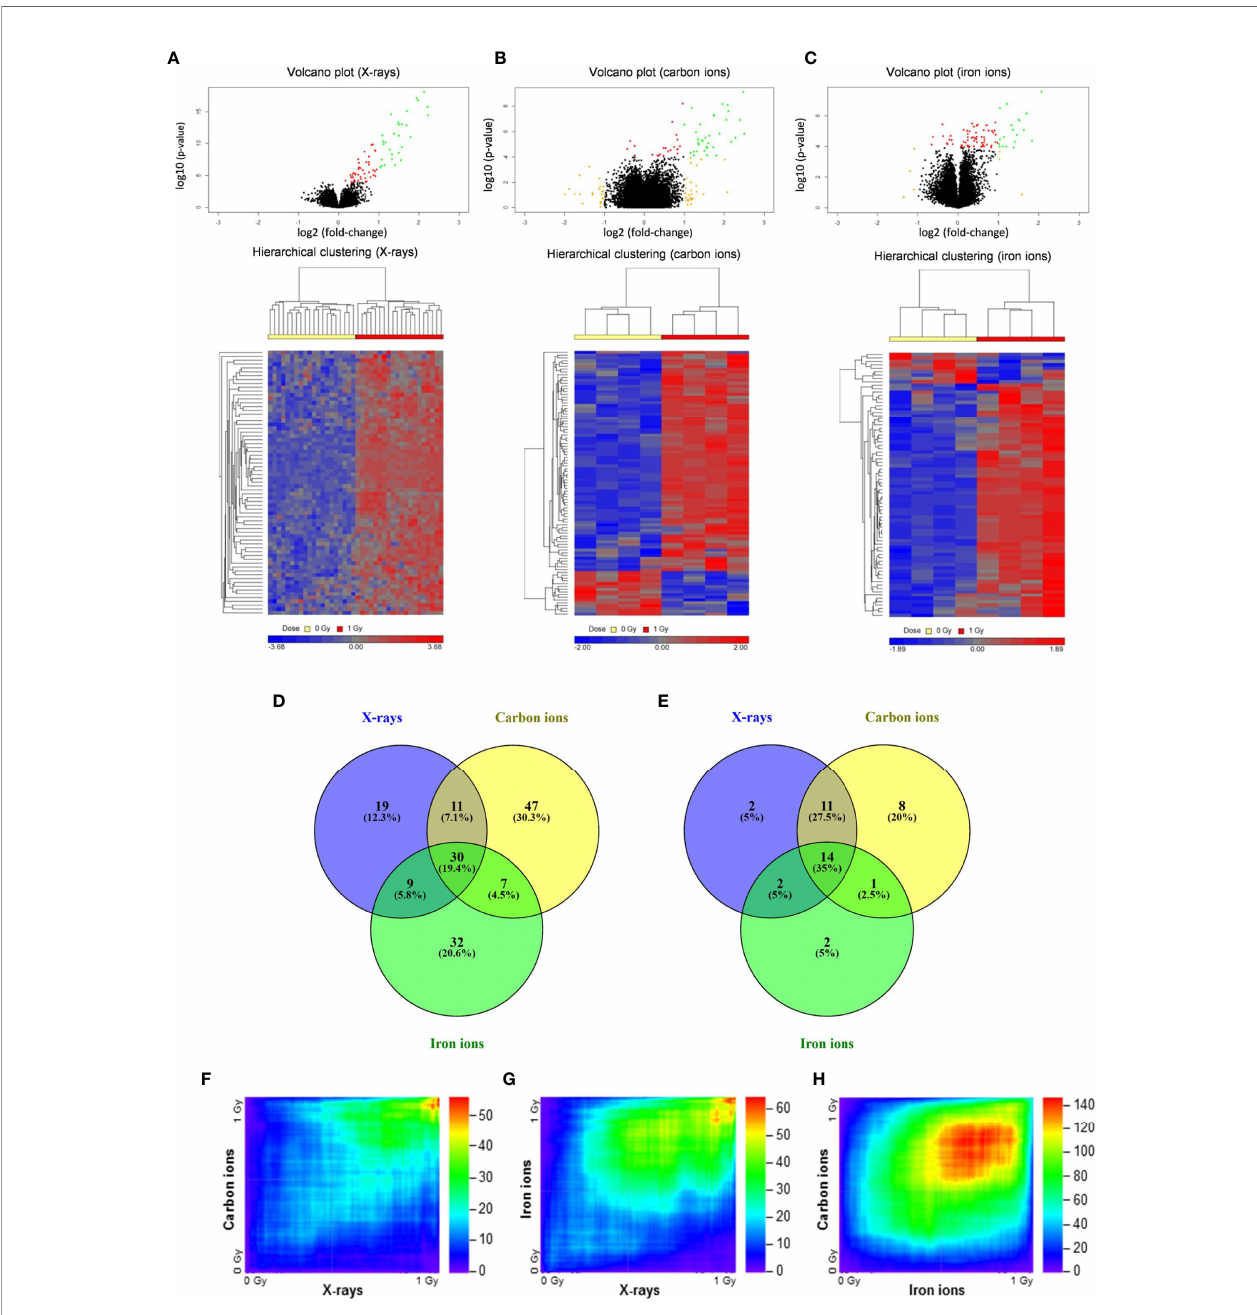
FIGURE 2 | Changes in gene expression in PBMCs after exposure to X-rays, carbon ions and iron ions. (A – C) Volcano plots and heatmaps of gene expression changes between controls and cells irradiated with X-rays (A) , carbon ions (B) or iron ions (C) at 8 h after exposure. Red points on volcano plots indicate genes with FDR <0.05, orange points indicate genes with |FC| >2 and green points indicate genes with FDR <0.05 and |FC| >2. Heatmaps show expression pro fi les of differentially expressed genes with an FDR <0.05. (D, E) Venn diagrams showing overlap in differentially expressed genes with FDR <0.05 (D) or FDR <0.05 and |FC| >2 (E) between the different radiation types. (F – H) Rank-rank hypergeometric overlap heatmaps indicating overlap in gene expression changes between X-rays and carbon ions (F) , between X-rays and iron ions (G) , and between carbon ions and iron ions (H) . Color scale bars indicate the log 10 -transformed hypergeometric p